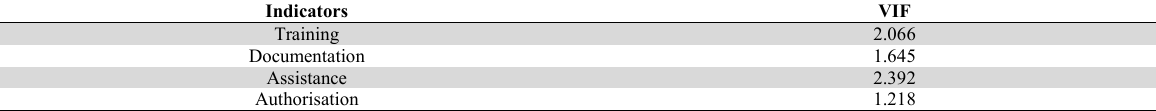
VIF and tolerance values for the second-order formative IS-Support